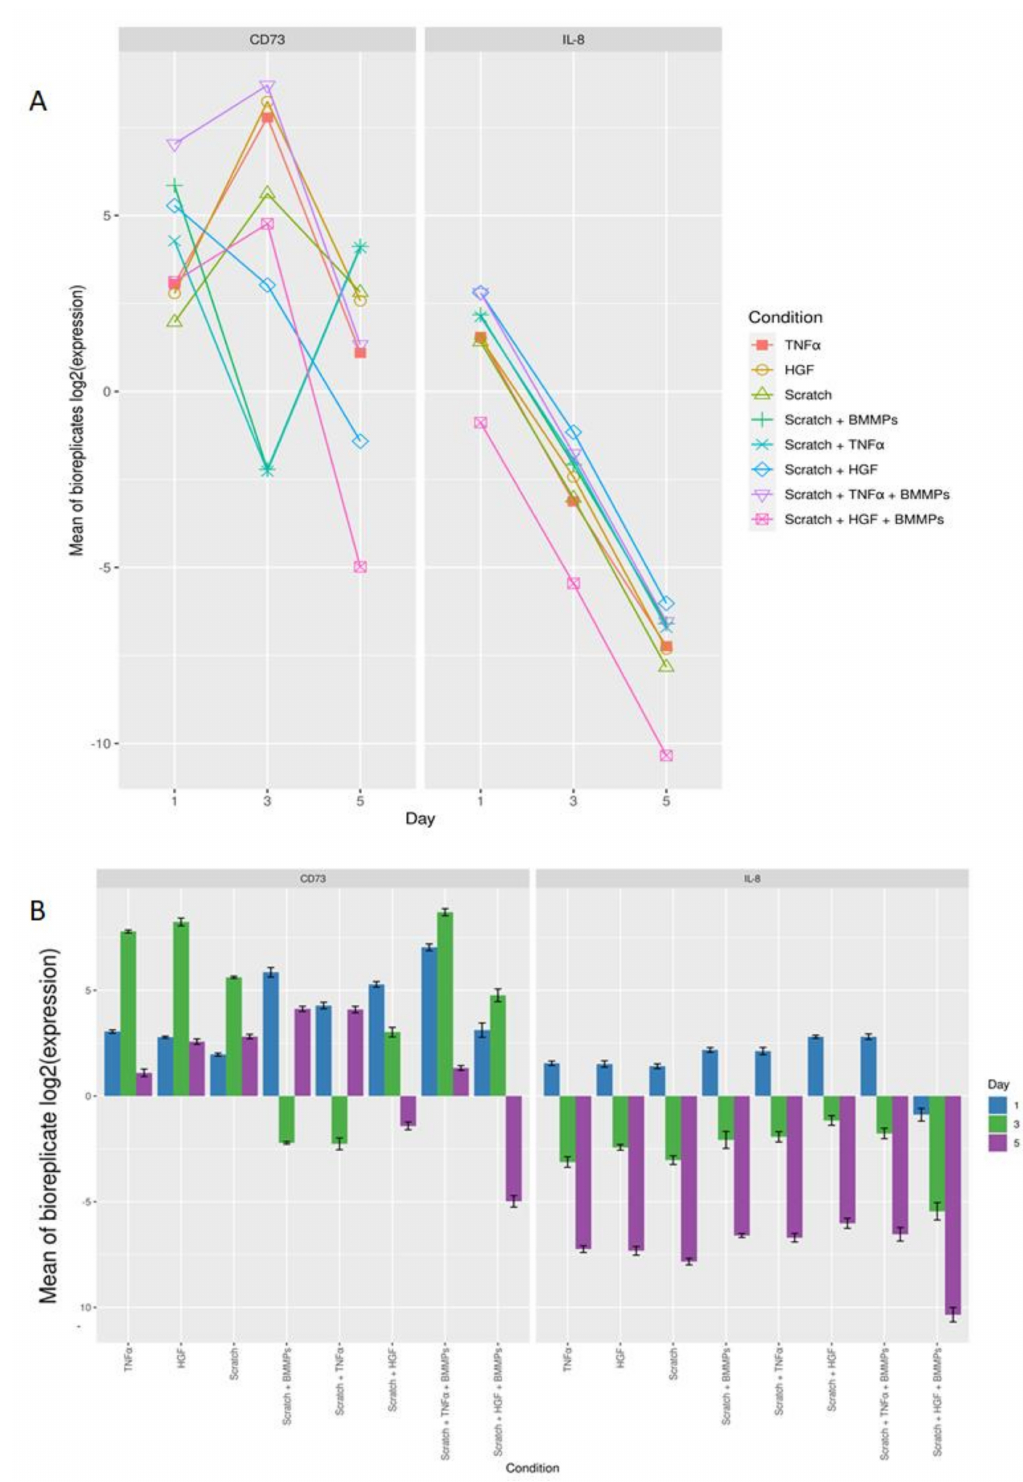
Figure 5. ( A ): Log2 expression for the mean of biological replicates for IL-8 and CD73 for all conditions at the three different time points. ( B ) Bar graph showing the log 2 expression mean of the biological replicates of CD73 and IL-8 for the eight different conditions on day one, day three, and day